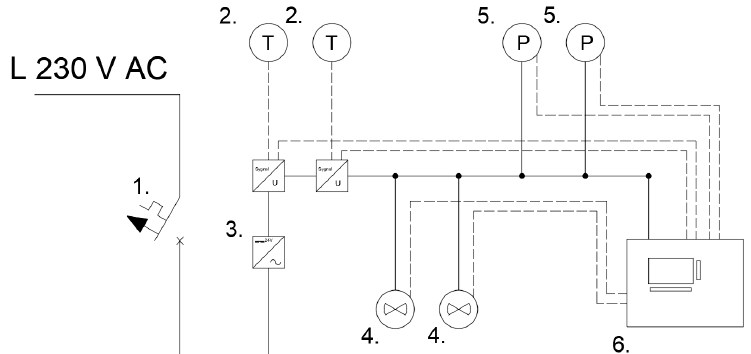
Figure 4. Diagram of the measuring system: (1) the overcurrent circuit breaker, (2) the temperature sensors with the signal/voltage transducers, (3) the DC power supply, (4) the flow sensors, (5) the pressure sensors, (6) the PLC unit.